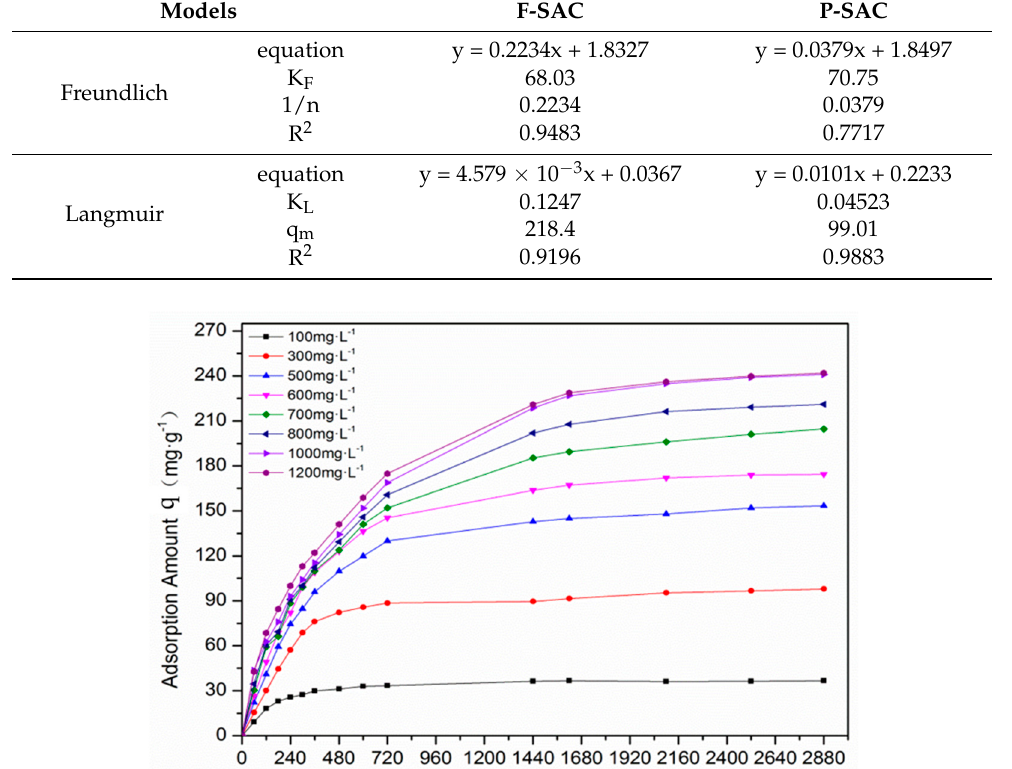
Table 3. Langmuir and Freundlich correlations for the adsorption process.